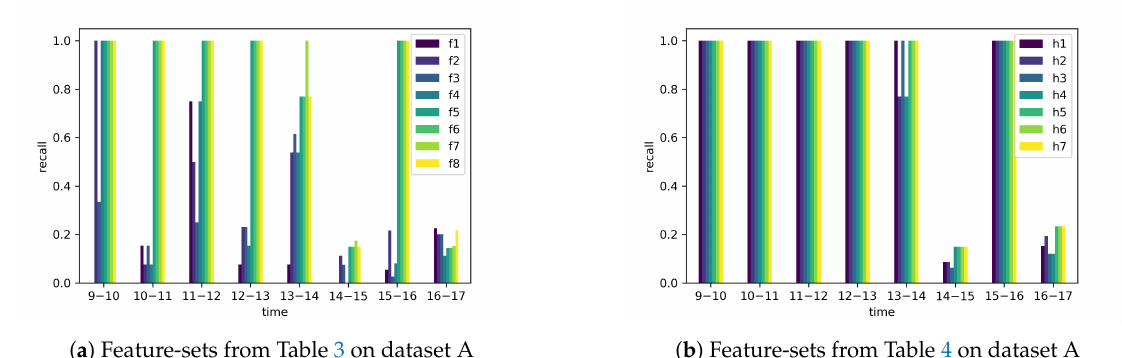
Figure 10. Recall for different feature sets.